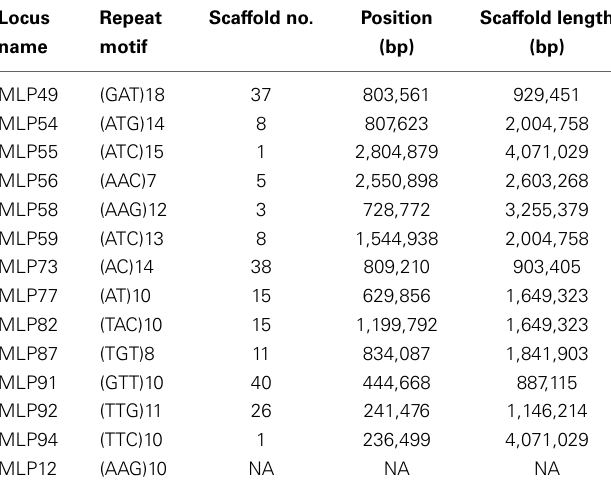
Table 1 | Characteristics and genome position of the 14 microsatellite loci, polymorphic in strain 98AG31, used for segregation and linkage disequilibrium analyses in M. larici-populina